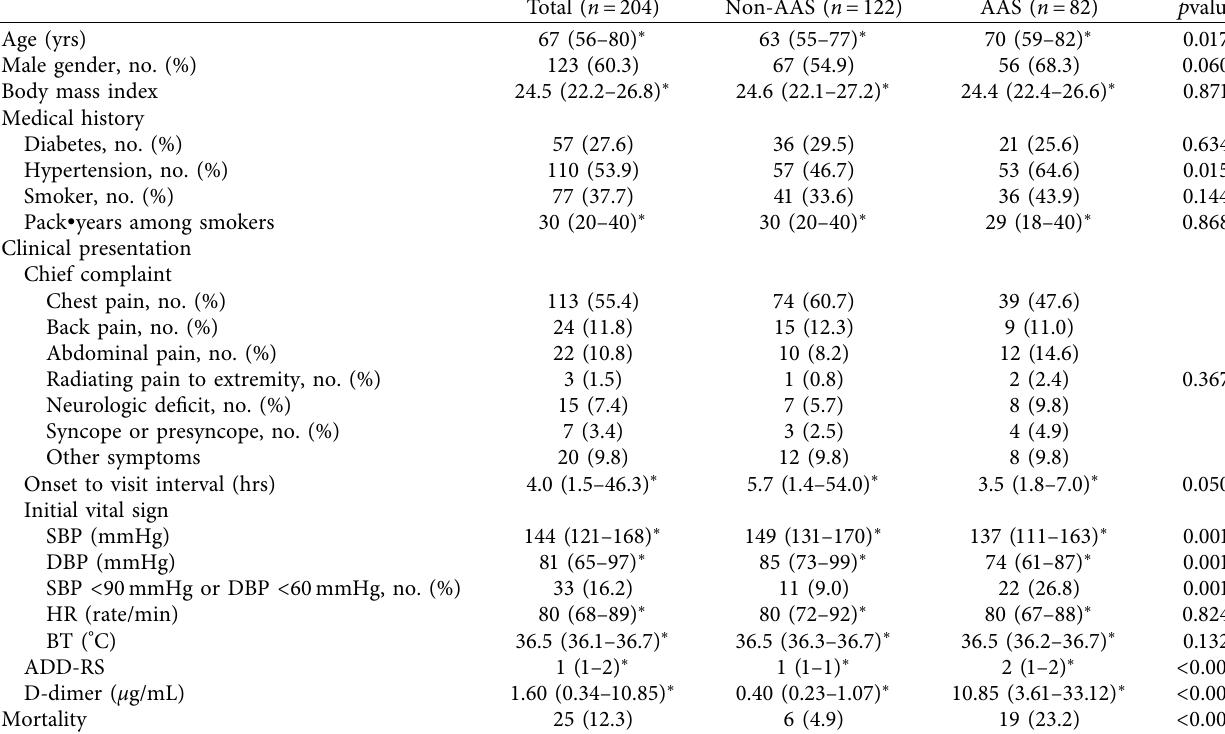
Table 1: Comparison of general characteristics between the AAS and non-AAS groups.